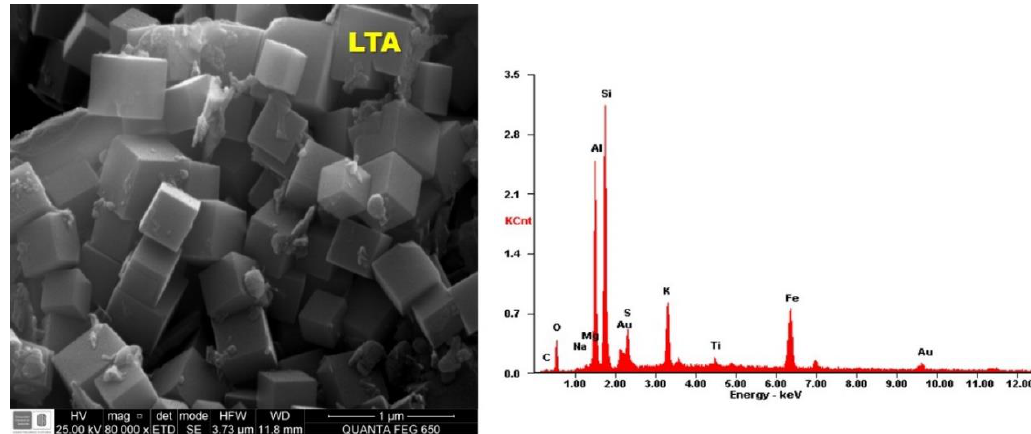
Figure 7. SE image ( left ) and EDS spectrum ( right ) of Na–A zeolite (LTA).